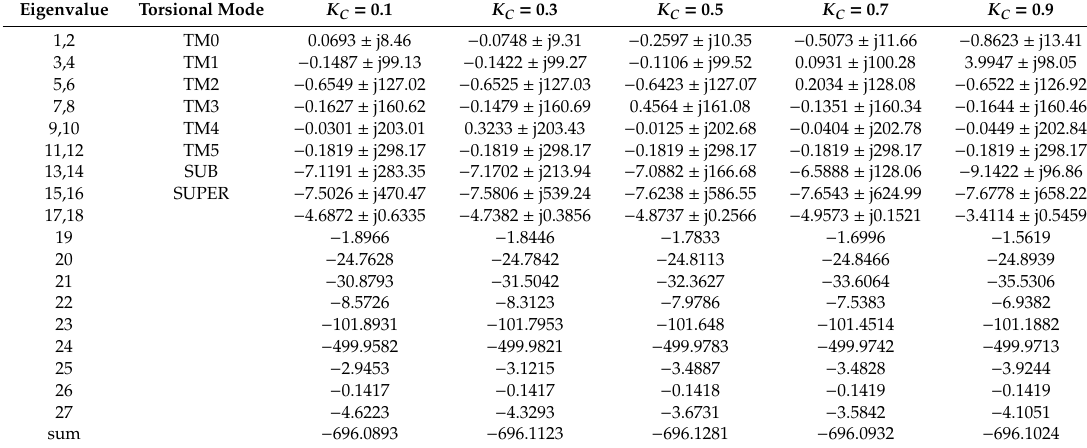
Table 4. System eigenvalues with di ff erent compensation levels K